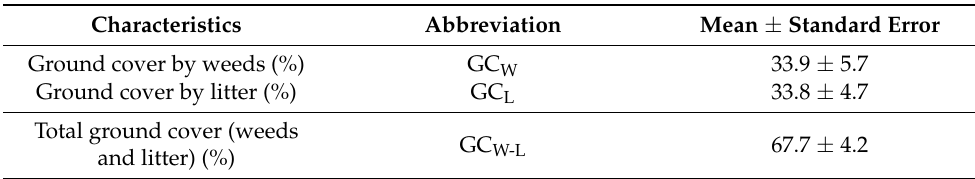
Table 3. Ground cover in maize cultivation plots (n =